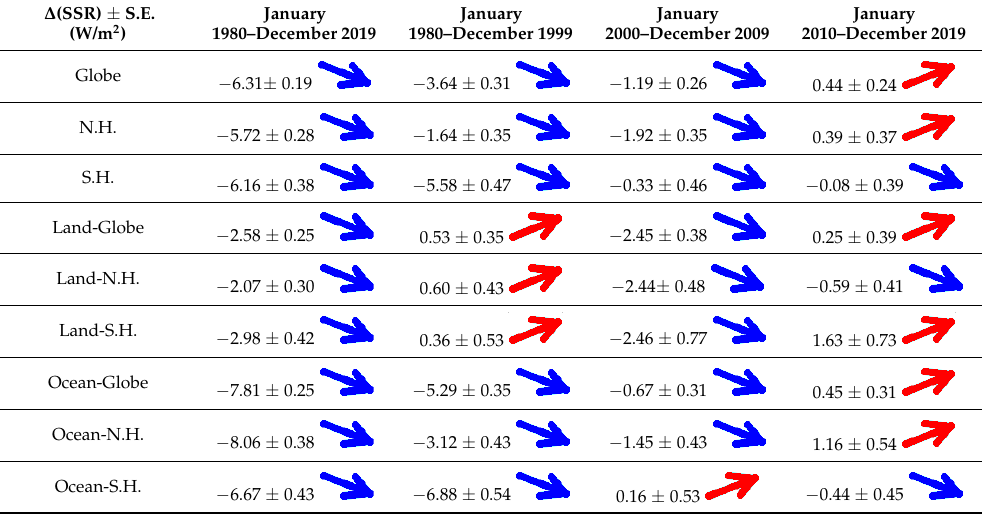
Table 2. Agreement between the GDB (Δ(SSR)) of MERRA -2 and GEBA stations over four different time periods. The percent number of GEBA stations for which same sign of GDB is found with the corresponding MERRA-2 pixels is given (in parentheses are the statistically significant trends), along with the average Δ(SSR) and the number of stations/pixels with brightening and dimming (shown in parentheses) for both GEBA and MERRA-2. Red and blue vectors indicate Brightening and Dimming, respectively.